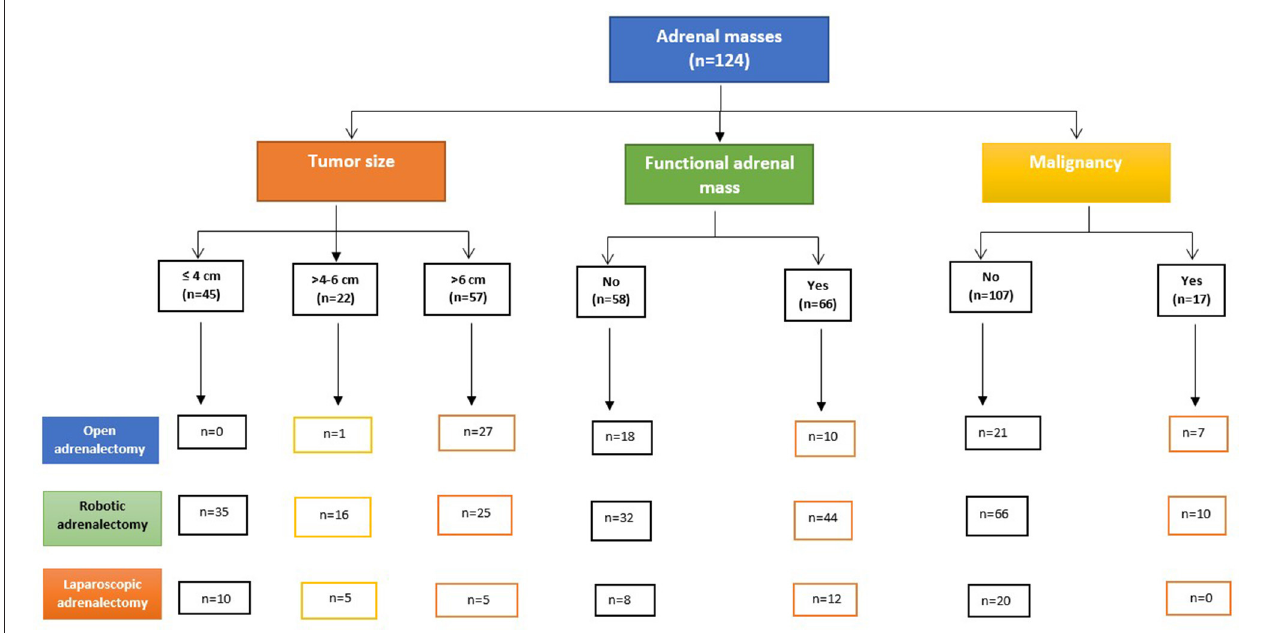
FIGURE 2 | Study design for surgical approaches based on tumor size, functionality, and malignancy.